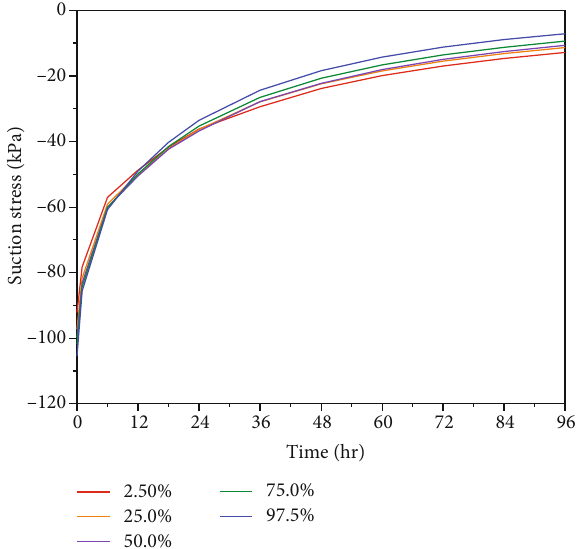
Figure 11: Soil suction stress at 1m depth of the observation pro fi le with di ff erent percentiles of the SWRC.